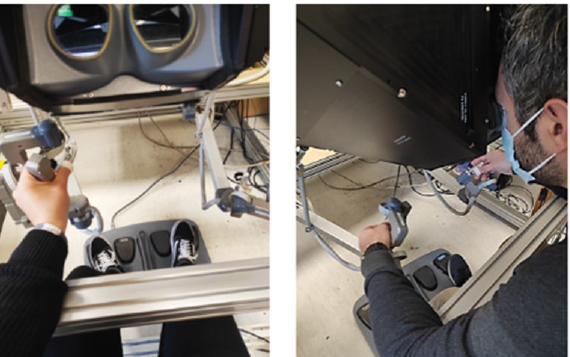
Figure 10. Functionality demonstration. MTM from the dVRK console was used to teleoperate the instrument mounted on the